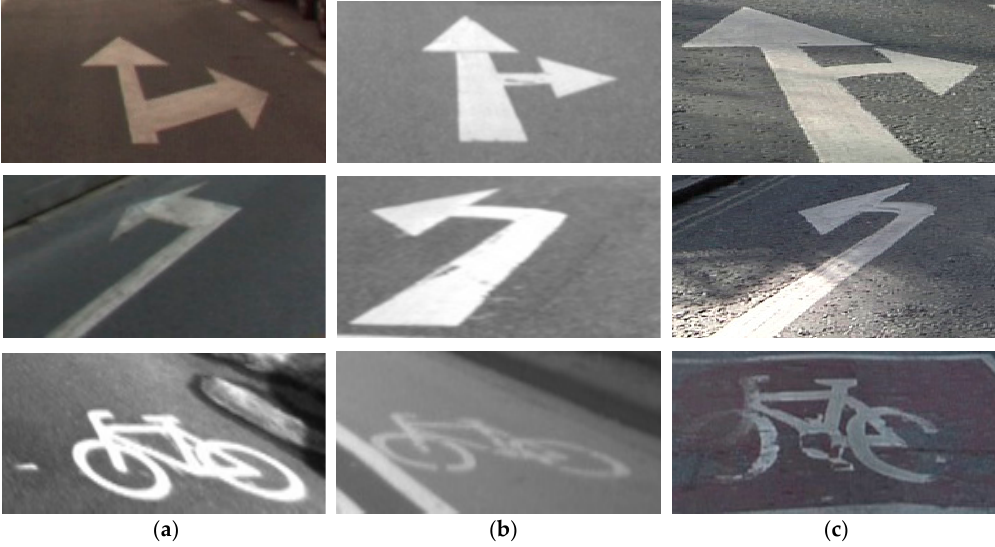
Figure 2. Different shapes of arrow markings observed in the image from the front-view camera in the vehicle for different datasets. ( a ) Malaga urban dataset image captured in Spain [16]. ( b ) Daimler dataset image captured in Germany [17]. ( c ) Cambridge dataset image captured in UK [18].